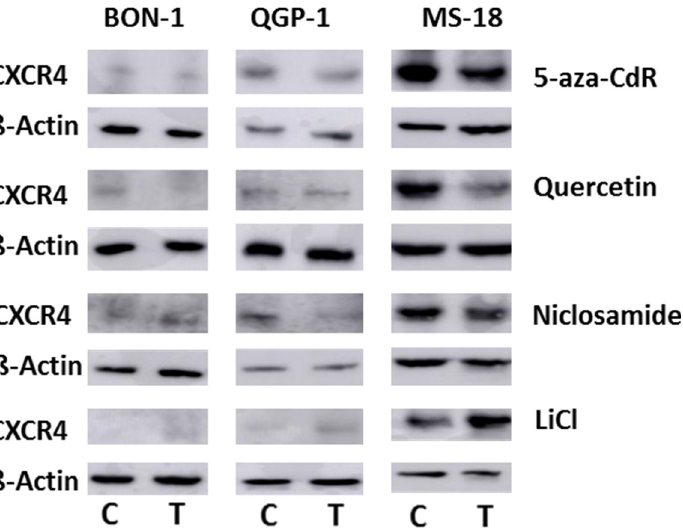
Figure 3. Immunoblot staining of CXCR4 in BON-1, QGP-1, and MS-18 either untreated (control) or after incubation with Wnt modulators. ß-Actin is exposed as the loading control. Immunohistochemical staining of CXCR4 was performed in all cell lines after incu- bation with the Wnt modulators (Figure 4). The strong basal expression of CXCR4 in MS- 18 cells is again confirmed by the presence of cytoplasmic, membraneous, and nuclear staining, while basal staining was weak in BON-1 cells and QGP-1 cells. Upon exposure to Wnt inhibitors, CXCR4-specific staining decreased alongside the percentage of CXCR4- positive cells. As in Western blot, this effect was strongest with quercetin in MS-18 cells and least pronounced for 5-aza-CdR in MS-18 cells. Since there was very low basal CXCR4 staining in QGP-1 cells, the effect of Wnt inhibition in immunohistochemistry were only reflected by the percentage of CXCR4-positive cells (Supplementary Material Figure S2). After LiCl exposure, CXCR4 staining increased in BON-1 and MS-18 cells while remaining unaffected again in QGP-1 cells.